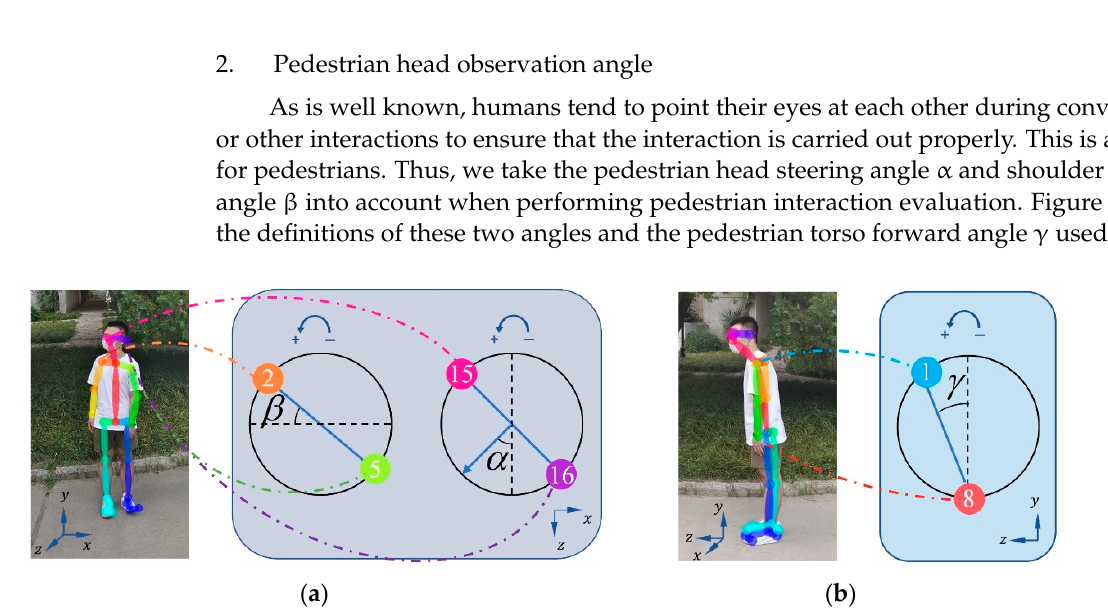
Figure 3. Schematic diagram of pedestrian distance and azimuth. On the XOZ plane, Points A and B represent the projections of pedestrians A and B, respectively.